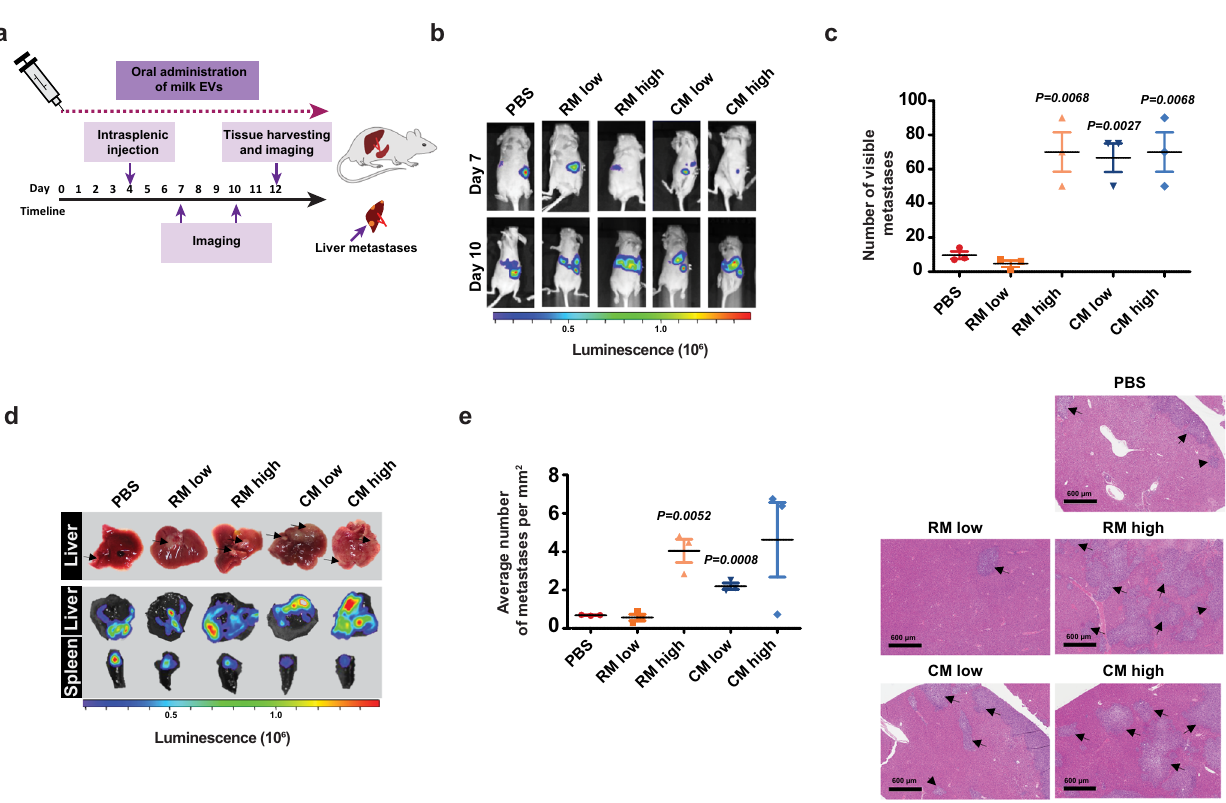
Fig. 4 Bovine milk-derived EVs increase metastasis of pancreatic cancer cells. a Schematic representation of intrasplenic injection of KPC pancreatic cancer cells and treatment timeline with milk-derived EVs. b Representative whole-body imaging of luciferase signal on day 7 and 10 following intrasplenic injection of luciferase-KPC cells and during daily treatment with RM and CM EVs (low dosage: 25 mg/kg; higher dosage: 50 mg/kg). c Number of visible metastases in control and milk-derived EVs fed mice ( n = 3). d Pathological and luminescence-based examination of liver metastases and quanti fi cation of visible metastases on the surface of the tissue ( n = 3). Black arrows point at KPC metastases visible at the surface of the organ. e Quanti fi cation of liver metastases normalized to liver surface area in H&E sections. Black arrows point at metastases in the liver tissue. All data are represented as mean ± s.e.m. Statistical signi fi cance was determined by unpaired two-tailed t